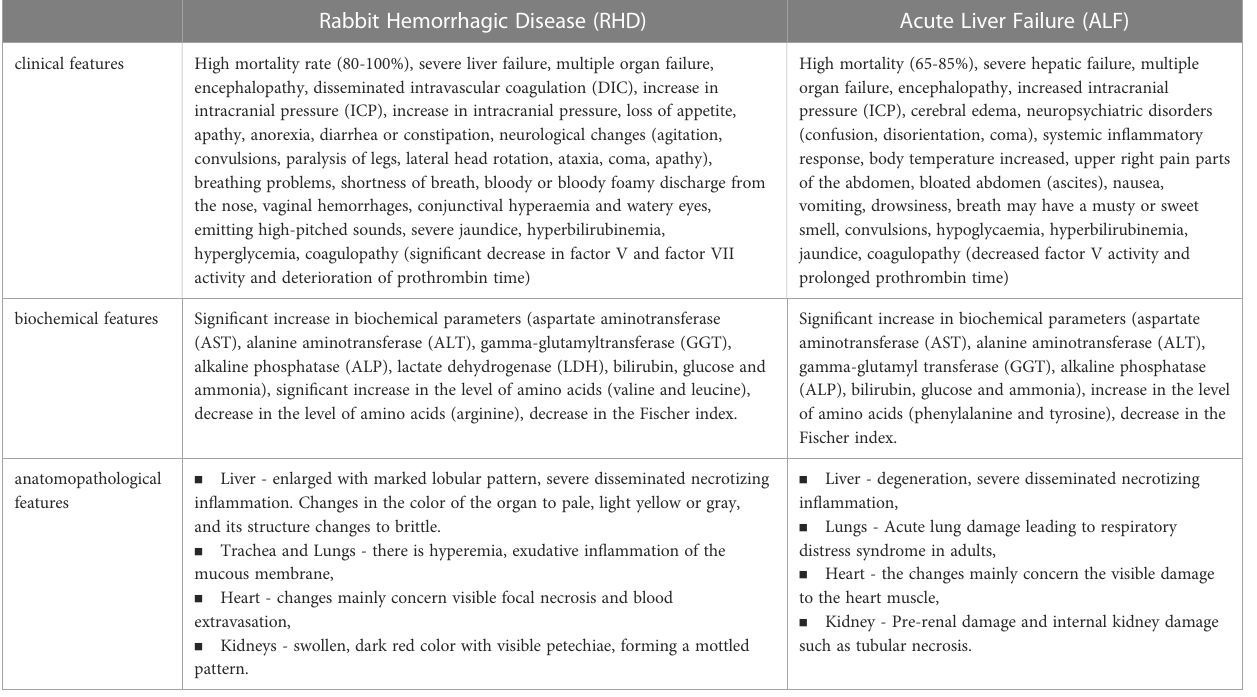
TABLE 1 Table showing the similarities between rabbit hemorrhagic disease (RHD) and acute liver failure (ALF) (2, 9, 10, 13, 53 – 55). Rabbit Hemorrhagic Disease